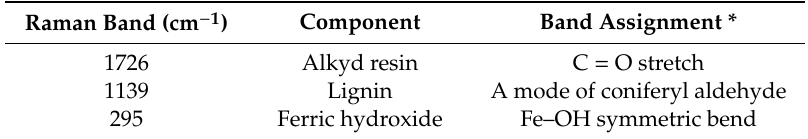
Figure 1. Cross-sectional view of coated wood surface and average Raman spectra obtained from the colored surface layer ( a ), S 2 ( b ), and coating-filled lumen ( c ). Scale bar: 10 µ m. Table 1. Summary of the Raman bands for preservative coatings and wood components used for Raman